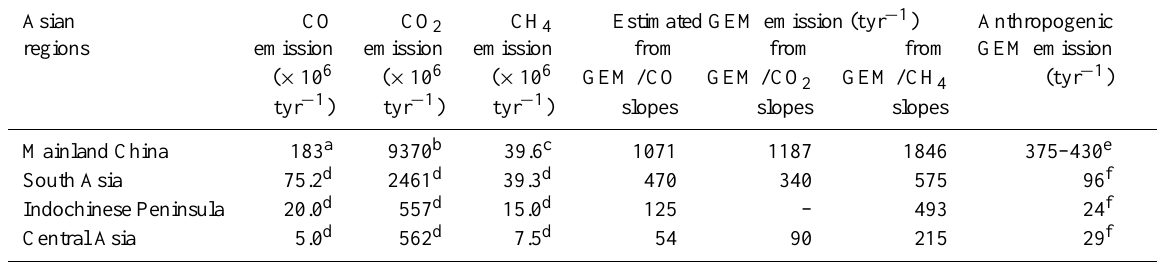
Table 3. Estimates of GEM emissions from mainland China, South Asia, the Indochinese Peninsula, and Central Asia using the observed correlation slopes and CO, CO 2 , and CH 4 inventories. A comparison to anthropogenic inventories is also included. Asian CO CO 2 CH 4 Estimated GEM emission (tyr − 1 ) Anthropogenic regions emission emission emission from from from GEM emission ( × 10 6 ( × 10 6 ( × 10 6 GEM/CO GEM/CO 2 tyr − 1 ) slopes slopes slopes Mainland